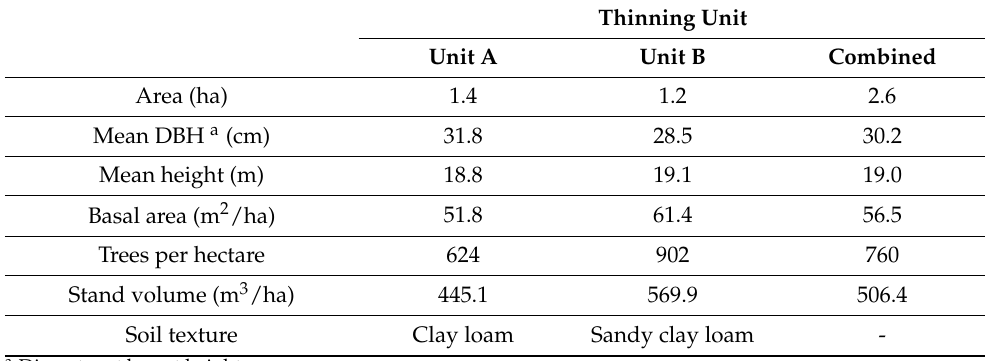
Figure 1. Map of the study site and images of the harvesters (( a ): Konrad Highlander wheeled harvester; ( b ): Neuson 132HVT tracked harvester) and forwarder (( c ): Novotný LVS720) used in row thinning operations. Table 1. Stand characteristics of the study site.